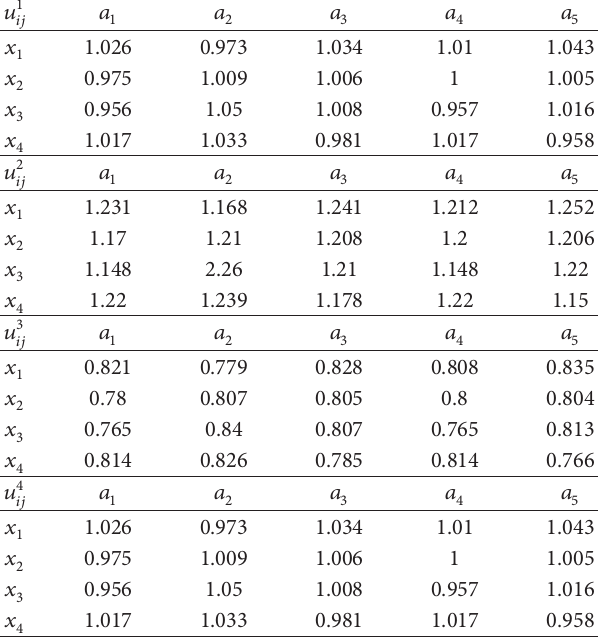
Table 3: Weight vector 𝑢 𝑘 𝑖𝑗 of each decision maker.